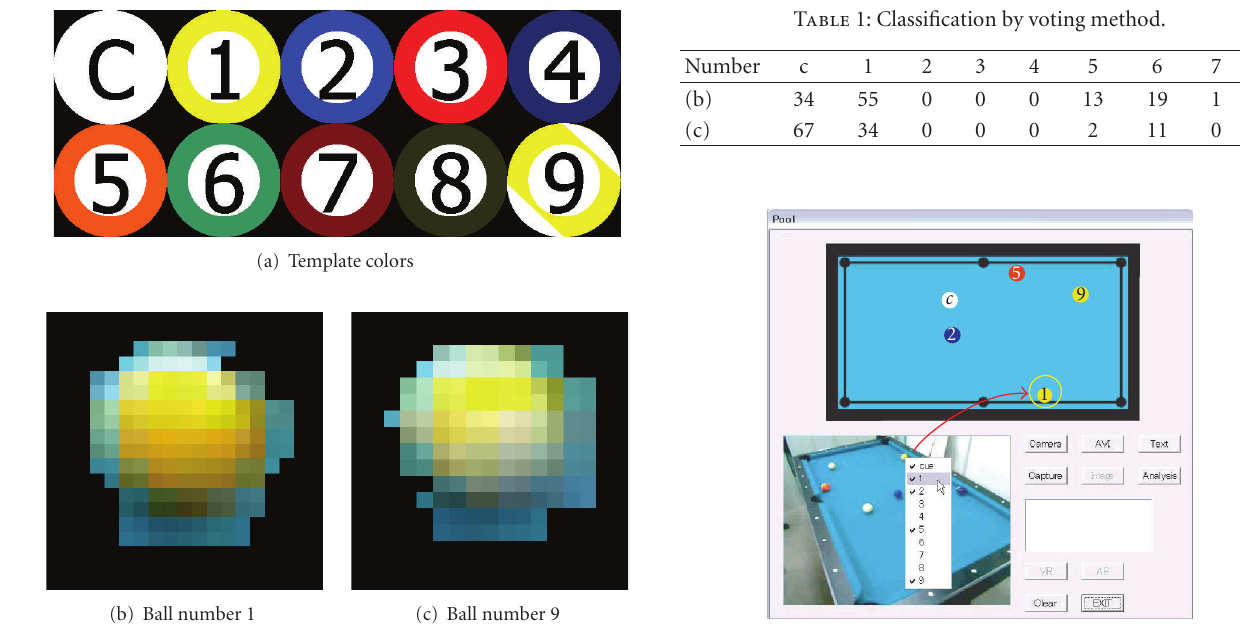
Figure 7: Identification of a ball number.